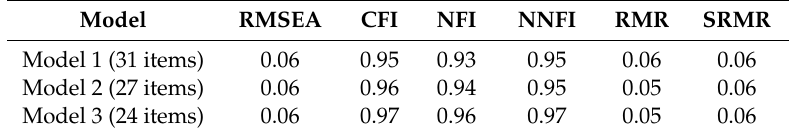
Table 2. Value of Goodness-of-fit indices for first measurement model of SCS-AE.